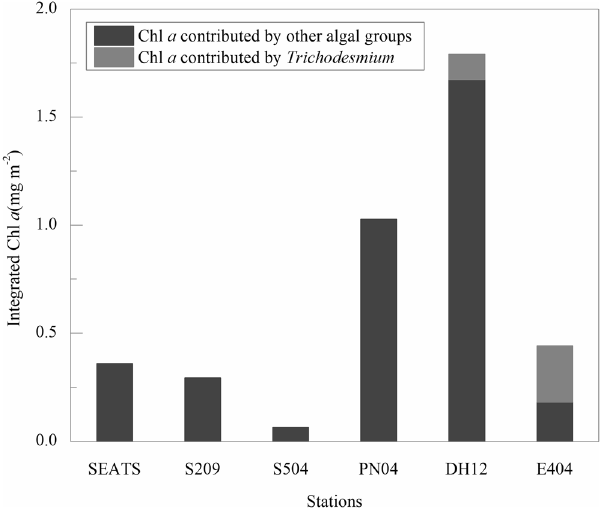
Figure 7. Chl a concentration contributed by Trichodesmium . Note for software: Origin 8.5 PRO (http://www. originlab.com/).